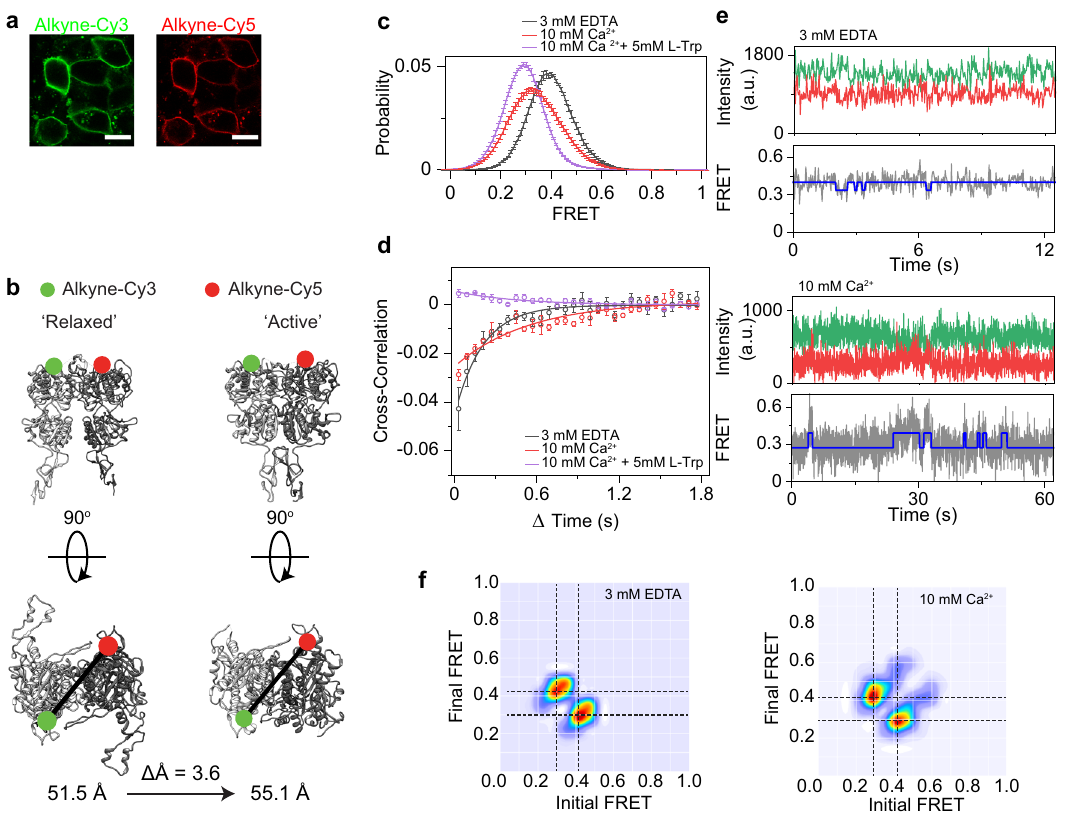
Fig. 2 D451UAA CaSR identi fi es transitions between two conformational states. a Representative confocal image of HEK293T cells expressing D451UAA and labeled with Alkyne-Cy3 (left) and Alkyne-Cy5 (right). Scale bar, 15 µ m. b Ribbon representation of crystal structures PDB ID: 5K5T (left) and PDB ID: 7DTV (right) showing approximate location of D451UAA labeling. Measured distance is between D451 C α represented by black line. c smFRET population histogram in the presence of 3 mM EDTA, 10 mM Ca 2 + , or 10 mM Ca 2 + and 5 mM L -Trp. Data represent mean ± s.e.m. of n = 3 independent biological replicates. d Cross-correlation plots in the presence of 3 mM EDTA, 10 mM Ca 2 + , or 10 mM Ca 2 + + 5 mM L -Trp. Data represent ±s.e.m. of n = 3 independent biological replicates. Data was fi t to a single exponential decay function. e Sample single molecule traces of D451UAA in 3 mM EDTA (top) and 10 mM Ca 2 + (bottom) showing donor (green) and acceptor (red) intensities, corresponding FRET values (gray), and idealized FRET trajectory from HMM fi t (blue). f Transition density plot of D451UAA. Dashed lines represent the most frequently observed transitions and were used for multiple-peak fi tting of FRET